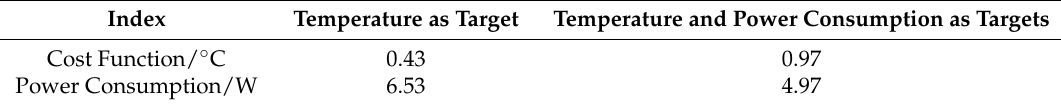
Table 1. Comparison of cost function value and power consumption with different control targets.